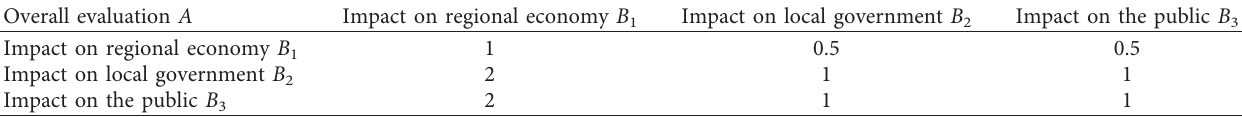
Table 3: Relative importance matrix.